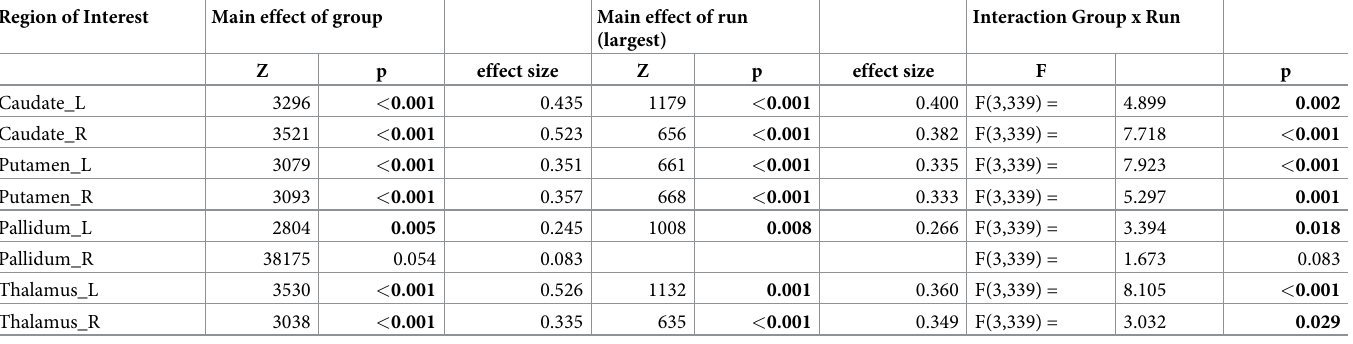
Bold font indicates statistical significance following Bonferroni correction for multiple